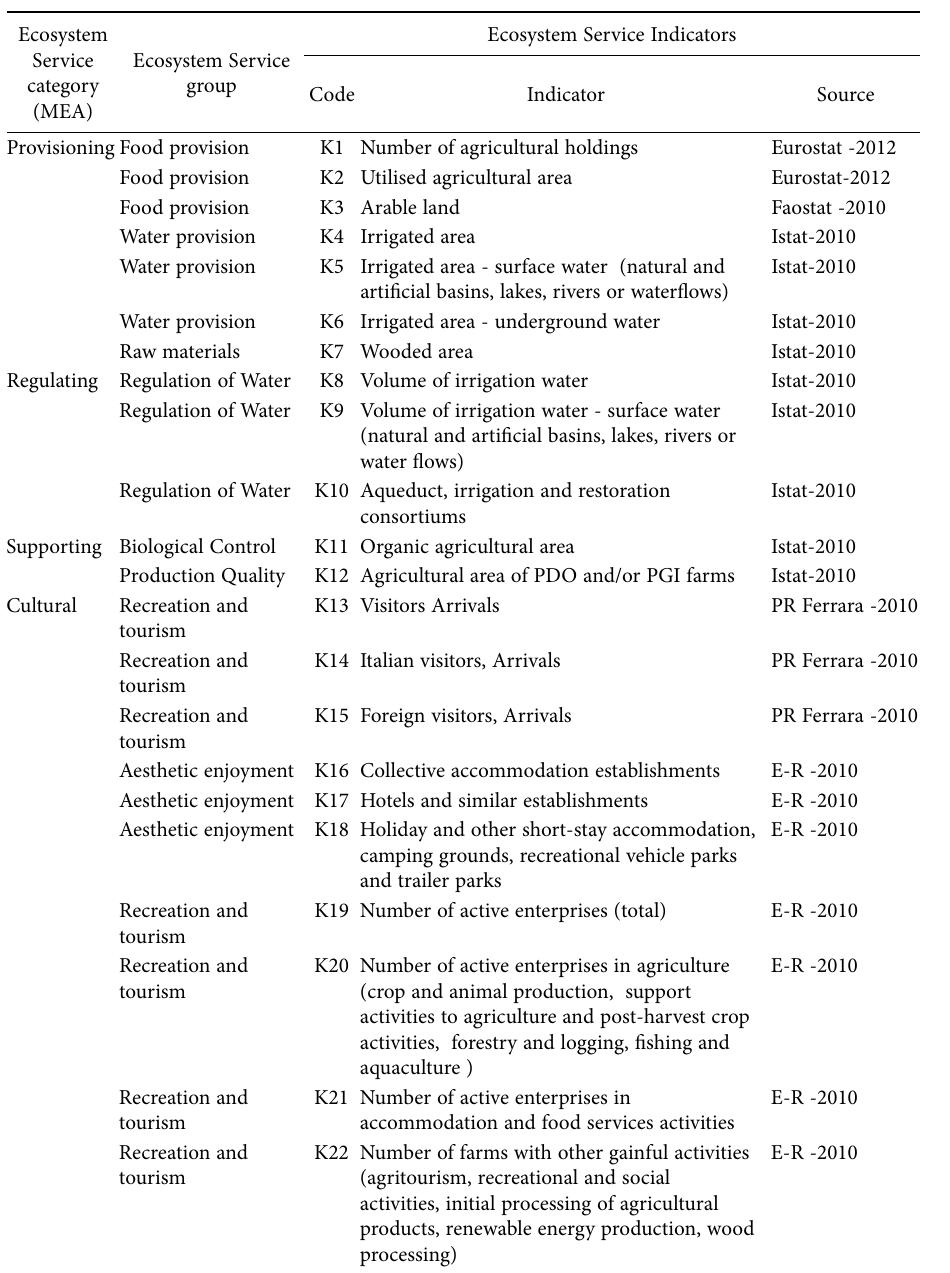
Table 2. Selected Ecosystem Services Indicators Ecosystem